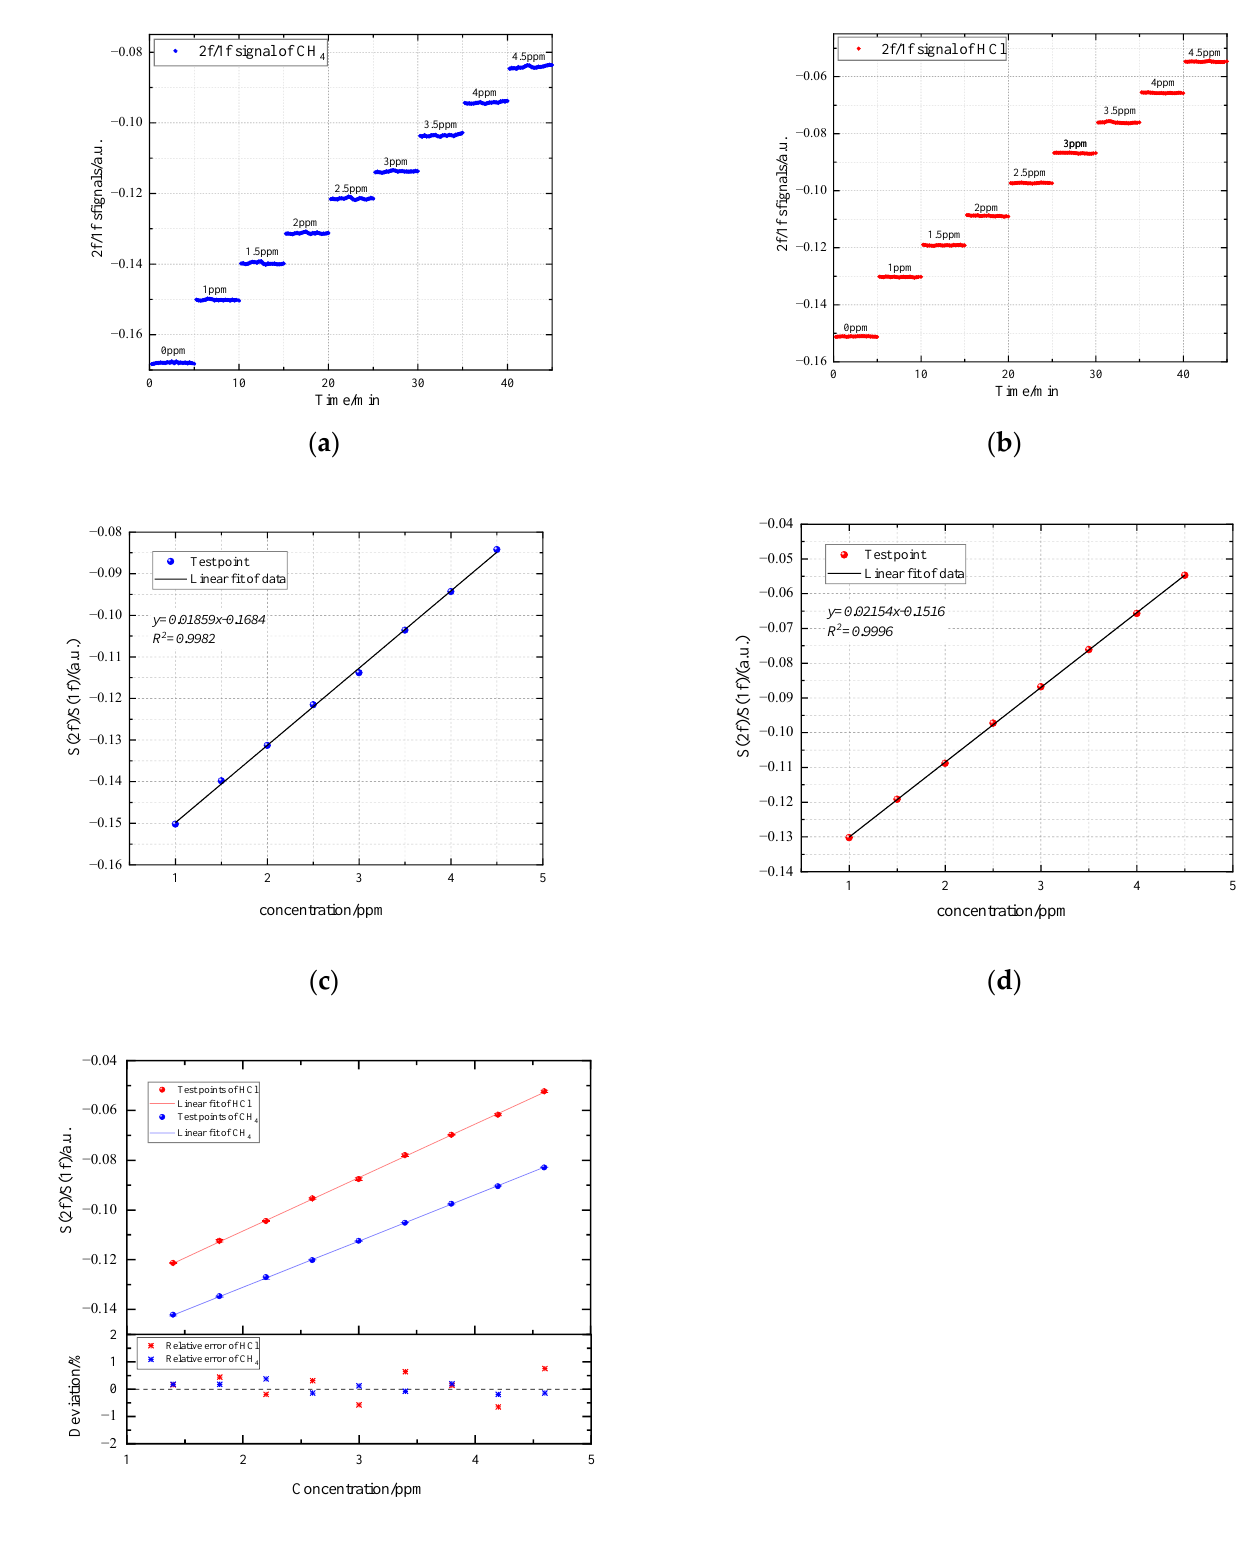
Figure 7. Measured first and second harmonic signals of CH 4 and HCl at different concentrations: ( a ) first harmonic signal of CH 4 .; ( b ) second harmonic signal of CH 4 .; ( c ) first harmonic signal of HCl.; ( d ) second harmonic signal of HCl.